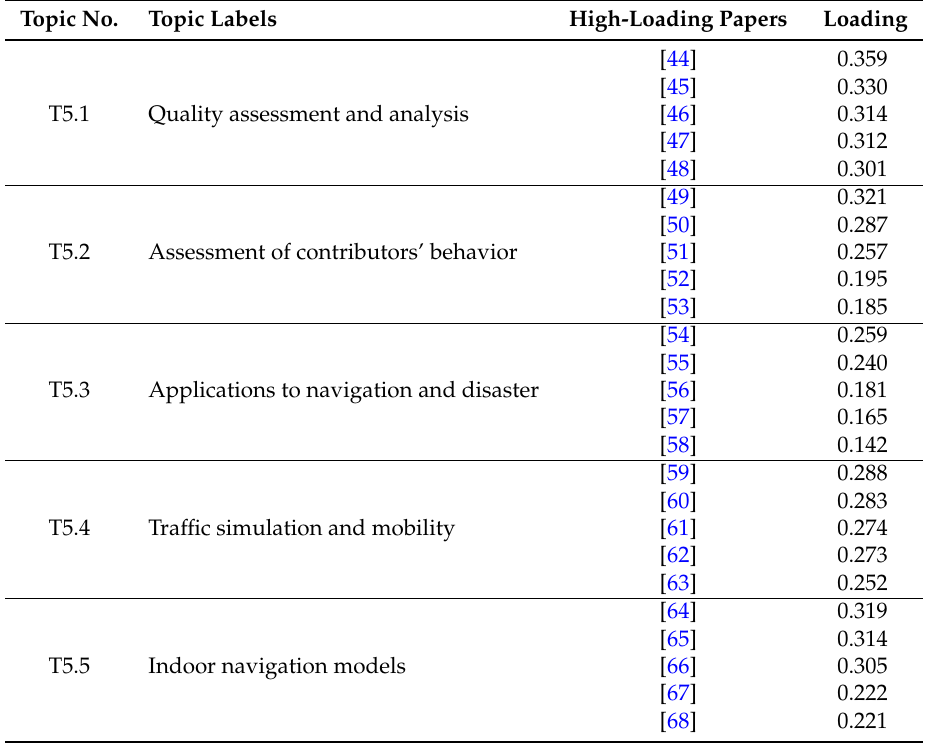
Table 7. High-loading research papers for five topic